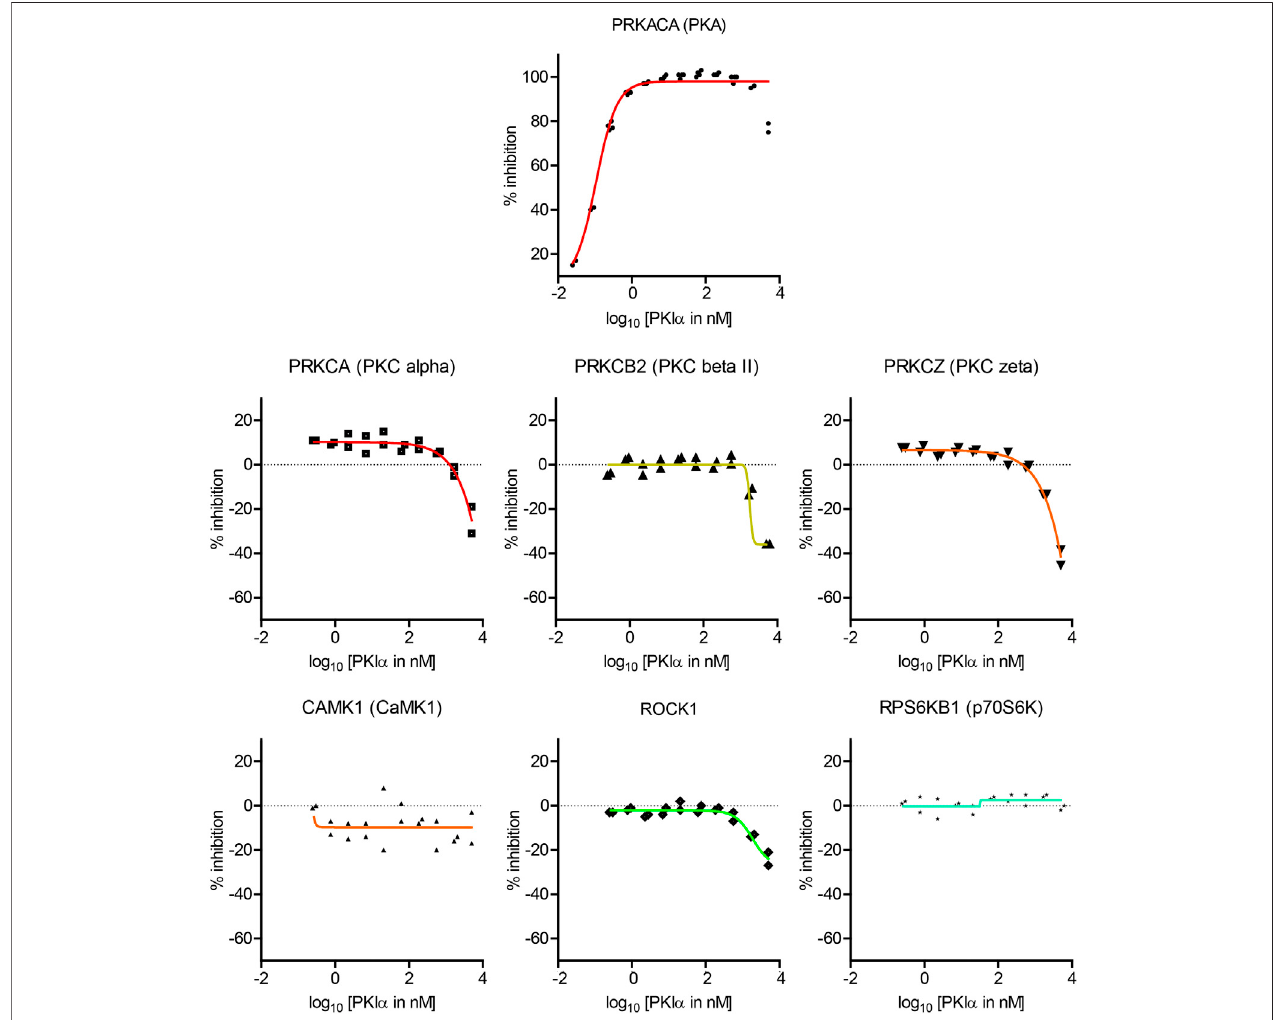
FIGURE4| Dose-responsecurvesoftheeffectsoffulllengthPKI α onkinaseactivity.Dose-responsecurveoffulllengthPKI α ontheactivitiesofsevenkinases.Note a negative value in % inhibition means PKI facilitates kinase activity. N (cid:1) 2 for each concentration. The graph shows individual replicates (staggered symbols) and fi tted